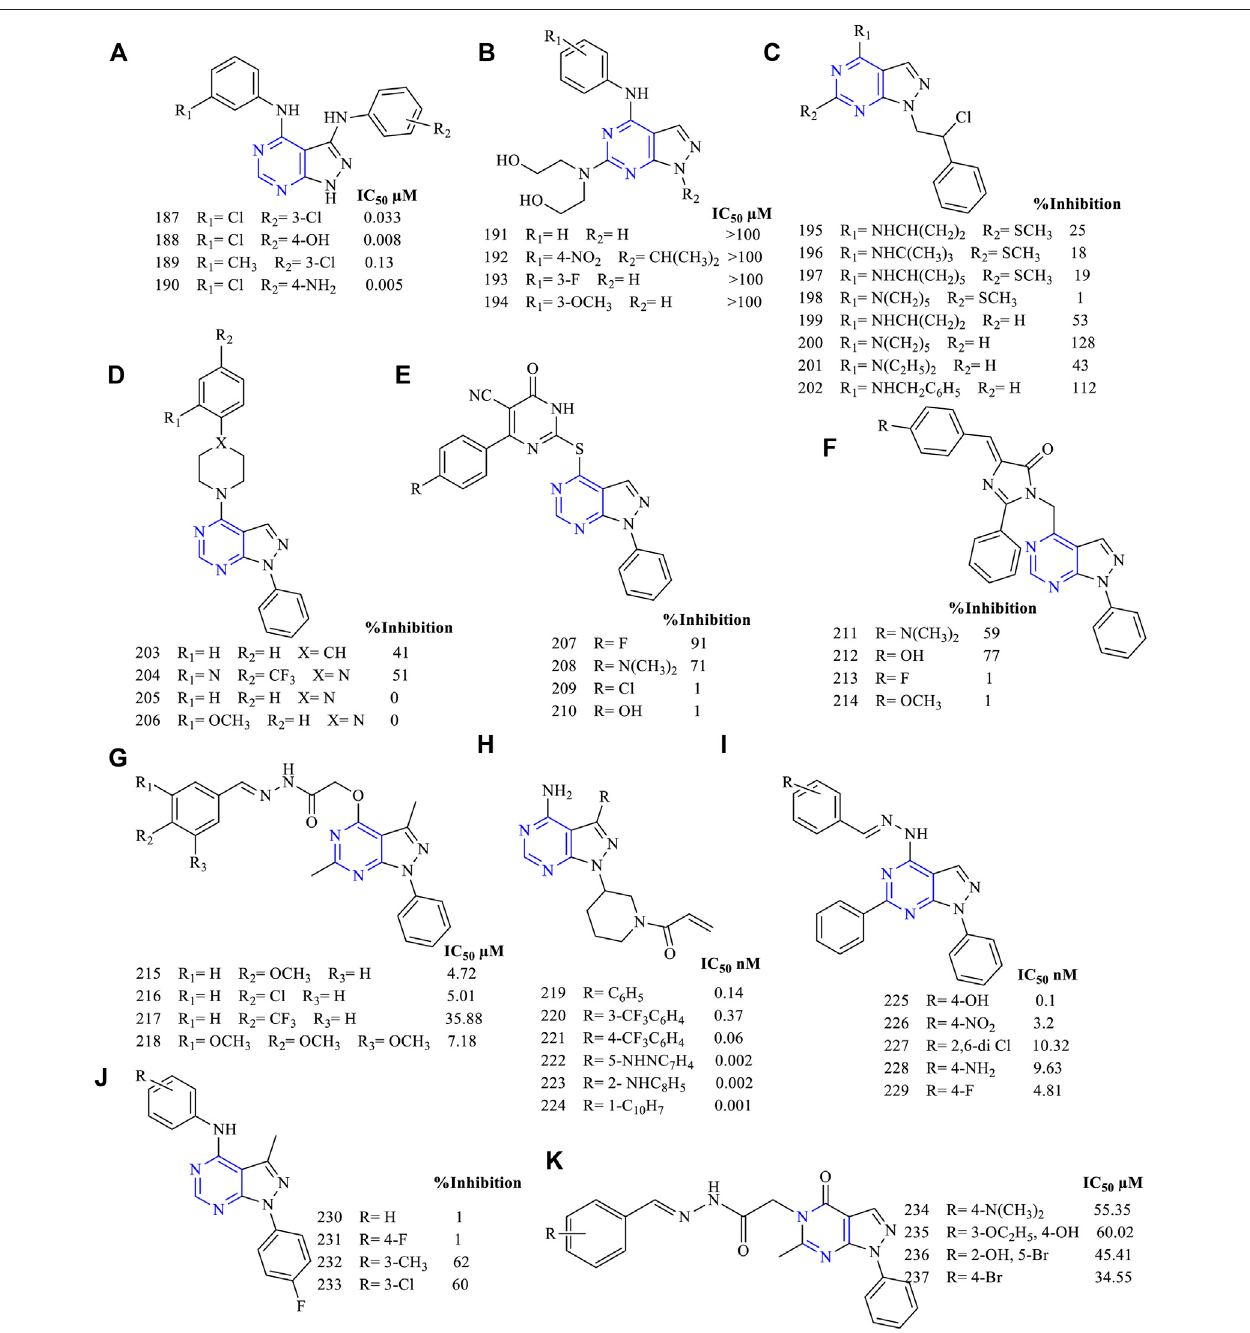
FIGURE 15 | Chemical structure of (A) 4-(phenylamino) pyrazolo[3,4- d ]pyrimidine pyrazolopyrimidine, (B) 4-substituted anilino-6-hydroxylaminopyrazolo[3,4- d ] pyrimidine, (C) 1-(phenyl ethyl)-4-substituted amino-6-thiopyrazolo[3,4- d ]pyrimidine, (D) piperidine-substituted pyrazolo[3,4- d ]pyrimidine, (E) pyrimidinone-substituted pyrazolo[3,4- d ]pyrimidine, (F) imidazole-substituted pyrazolo[3,4- d ]pyrimidine, (G) acetohydride derivatives of pyrazolo[3,4- d ]pyrimidine, (H) propanone derivatives of pyrazolo[3,4- d ]pyrimidine, (I) benzylidene derivatives of pyrazolo[3,4- d ]pyrimidine (J) 1-phenyl-3-methylpyrazolo[3,4- d ]pyrimidin-4-amine, and (K) N ′ -substituted benzylidene-2-(6-methyl-4-oxo-1-phenyl-1 H -pyrazolo[3,4- d ]pyrimidin-5(4 H )-yl)acetohydrazide.